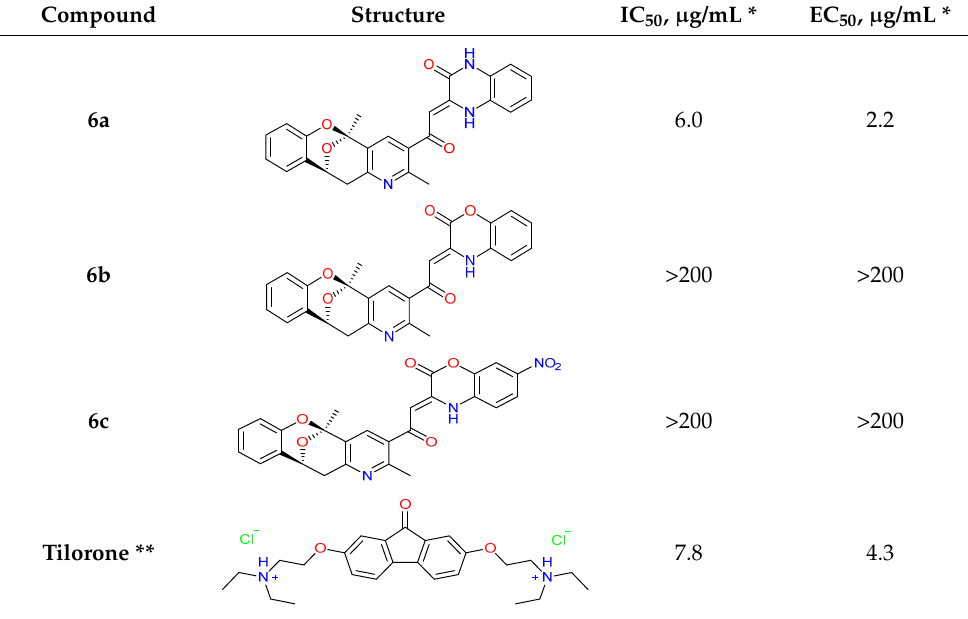
Table 1. Cont. Compound Structure